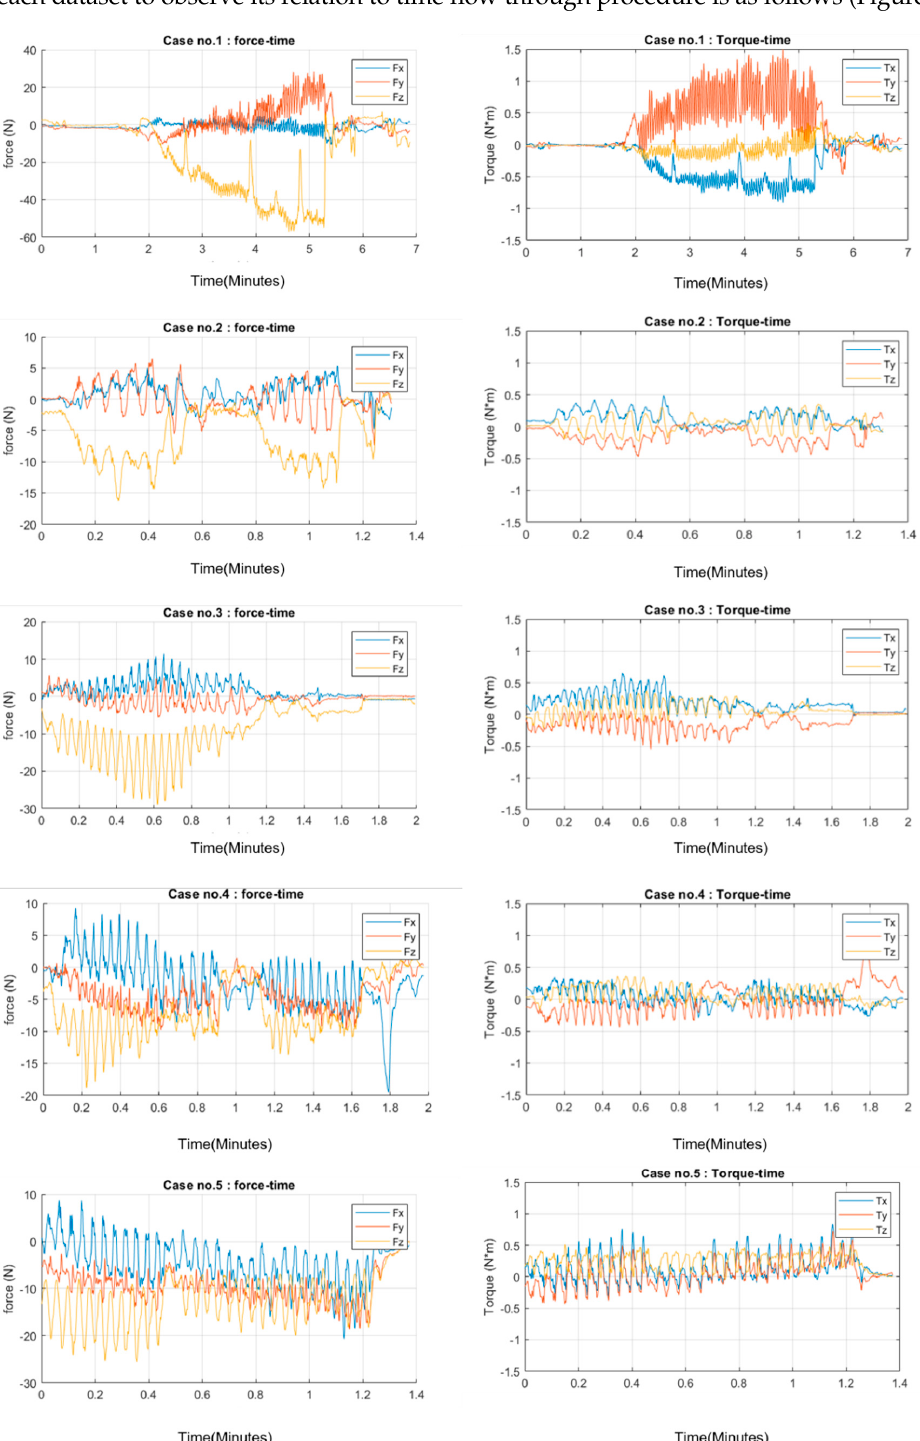
Figure 2. Three–dimensional force–torque characteristics’ representation through time of the primary trocar insertion procedure in all 5 cases. Fx: force on x–axis, Fy: force on y–axis; Fz: force on z–axis; Tx: torque on x–axis; Ty: torque on y–axis; Tz: torque on z–axis; N: newton, m: meter.